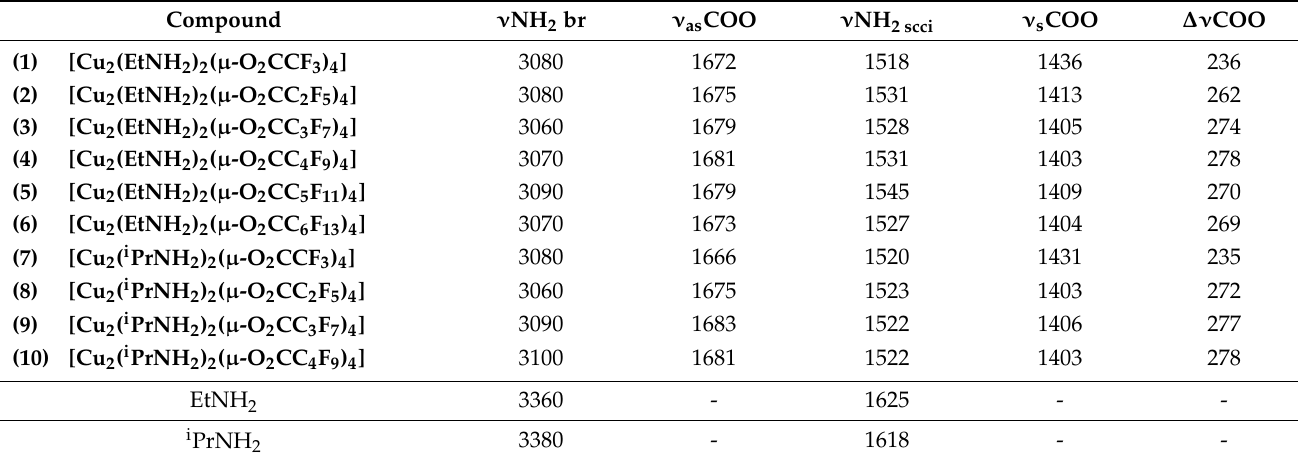
Table 1. Selected IR absorption bands (cm − 1 ) of studied compounds ( 1 – 10